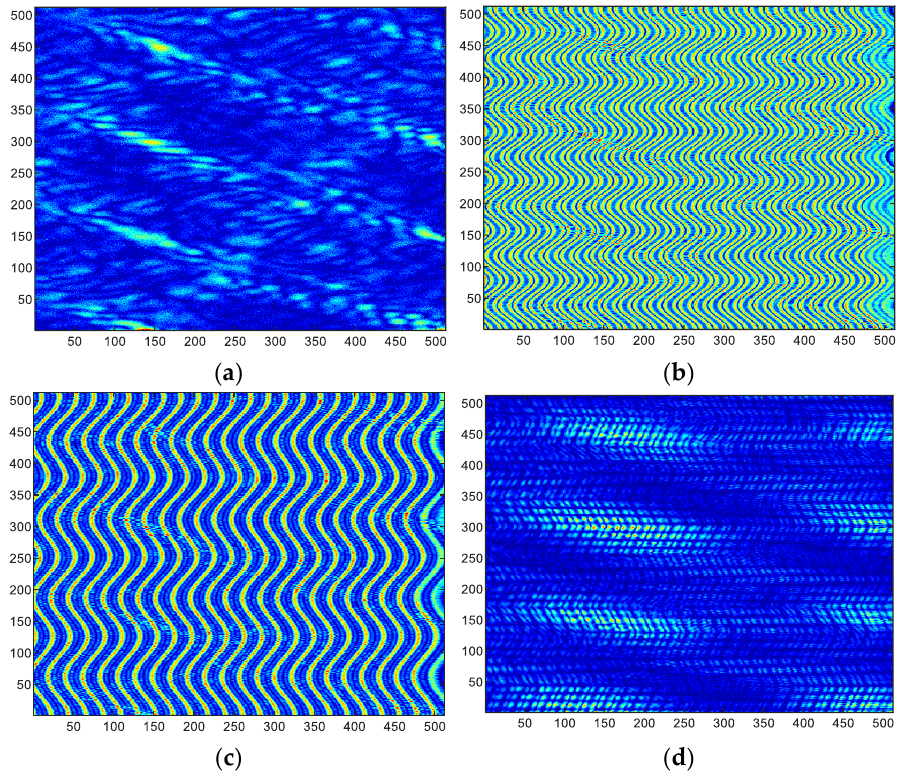
Figure 4. The images of four different classes of echo signal matrix. ( a ) Class1, ( b ) Class2, ( c ) Class3, ( d ) Class4.